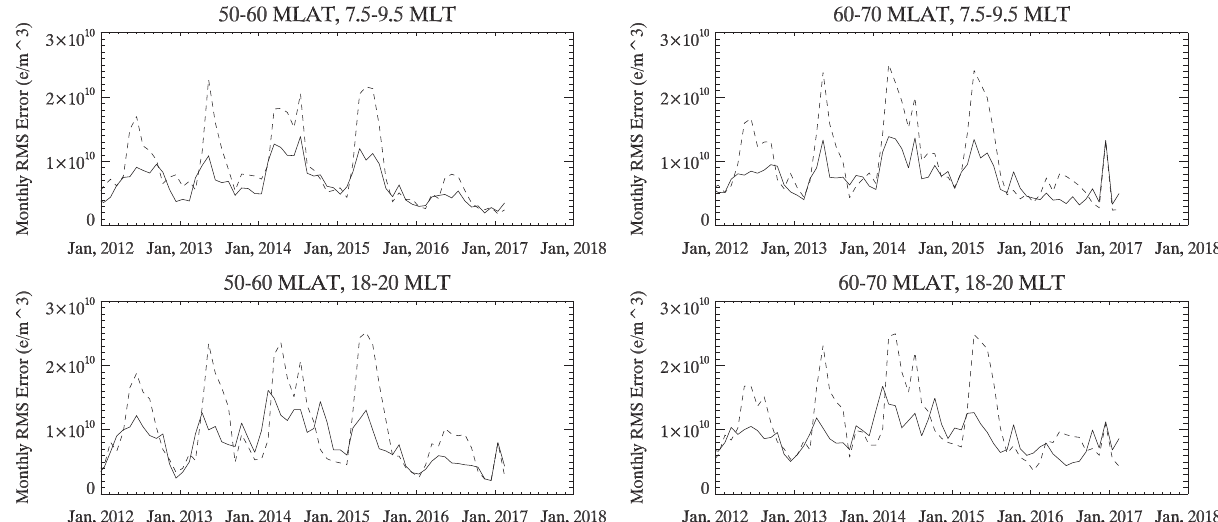
Fig. 7. Same as Figure 6 but for DMSP satellite F18. The top plots correspond to the 7.5 – 9.5 MLT bin, the bottom plots correspond to the 18 – 20 MLT bin, the left plots are for the 50 (cid:1) – 60 (cid:1) N geomagnetic latitude bin, and the right plots are for the 60 (cid:1) – 70 (cid:1) N geomagnetic latitude